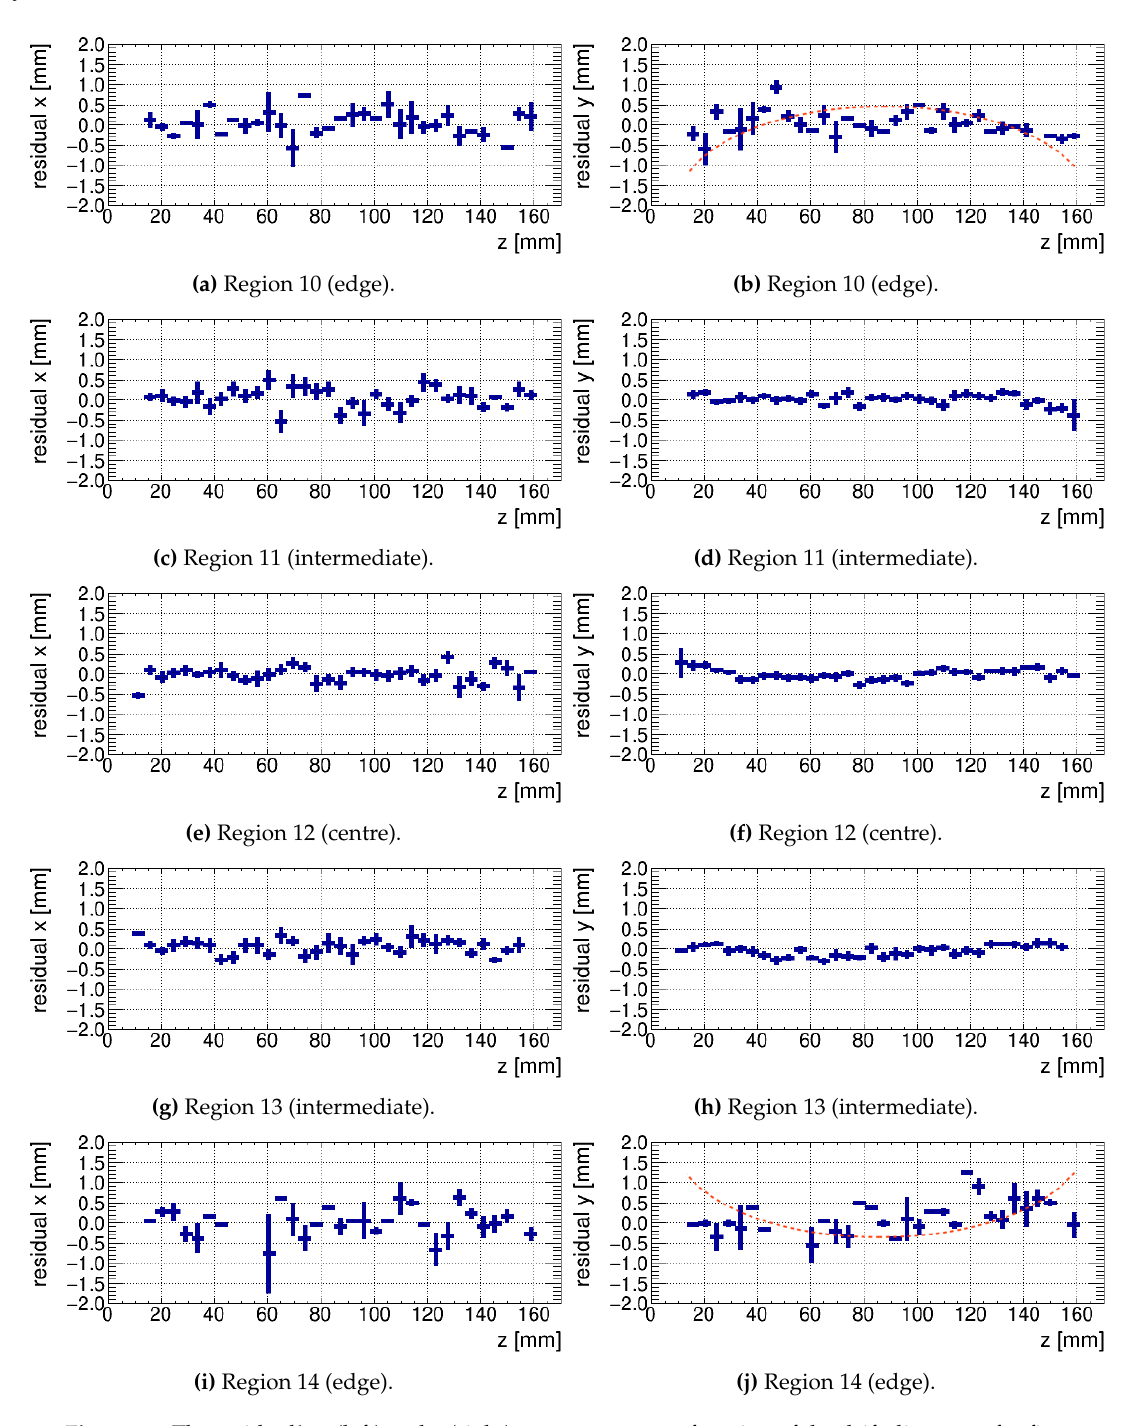
Figure 10. The residual’s x (left) and y (right) components as a function of the drift distance z for five selected regions. Dashed orange lines are used to illustrate a possible